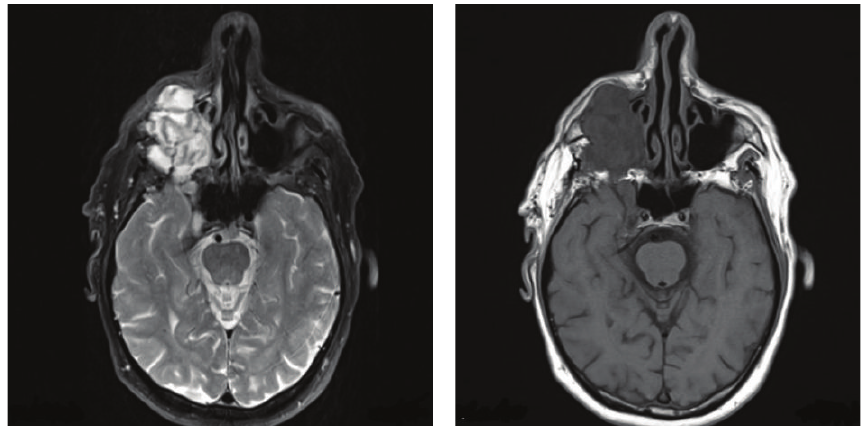
Figure 1: Axial MRI showing lobulated mass in the right maxillary antrum extending anteriorly into the subcutaneous tissue of the cheek and posteriorly into the infratemporal fossa.